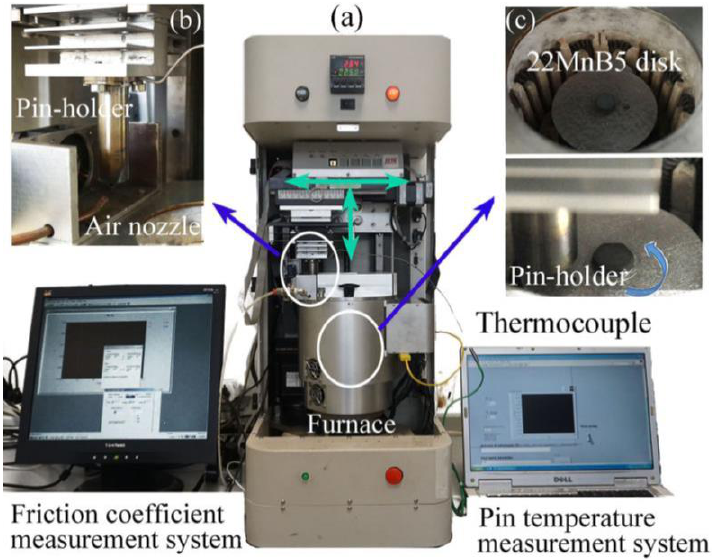
Figure 2. ( a ) UMT-3 tribometer; ( b ) pin cooling system; ( c ) heating chamber.